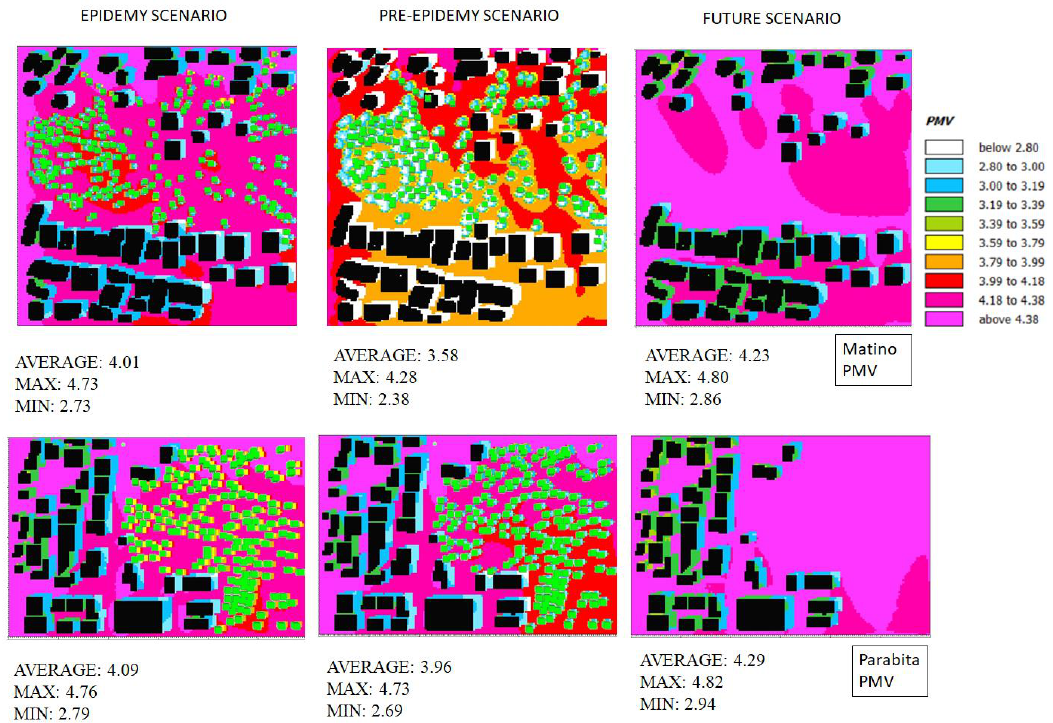
Figure 9. Spatial distribution of PMV at 15:00 for Matino (top) and Parabita (bottom) inside the street canyon (top) and within the olive grove (bottom) (see Figure 3 for the position of receptors R1, R2, R3 and R4).